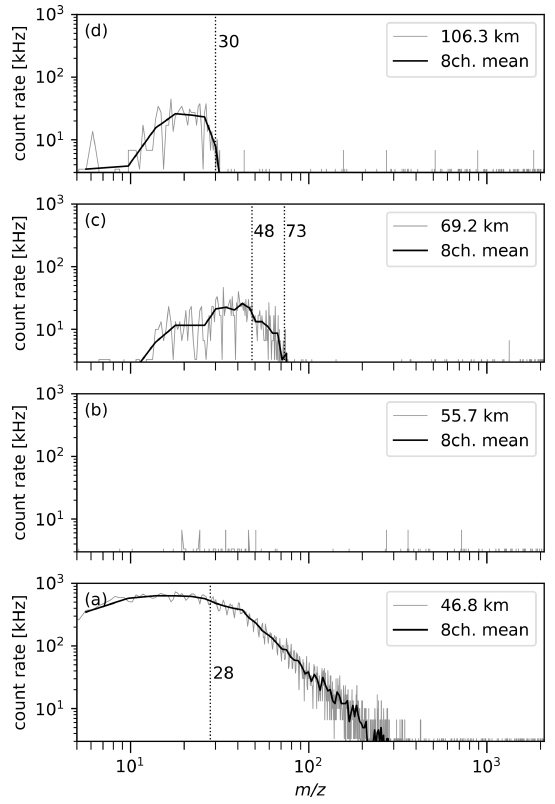
Figure 6. Positive-ion mass spectra at four different altitudes dur- ing ascent in logarithmic scales. Spectrum (a) shows the residual gas spectrum from the internal ion source before ejecting the cap. Spectrum (b) , (c) and (d) show natural ambient ions. The vertical resolution for spectrum (b) , (c) and (d) is 1426, 1270 and 678m